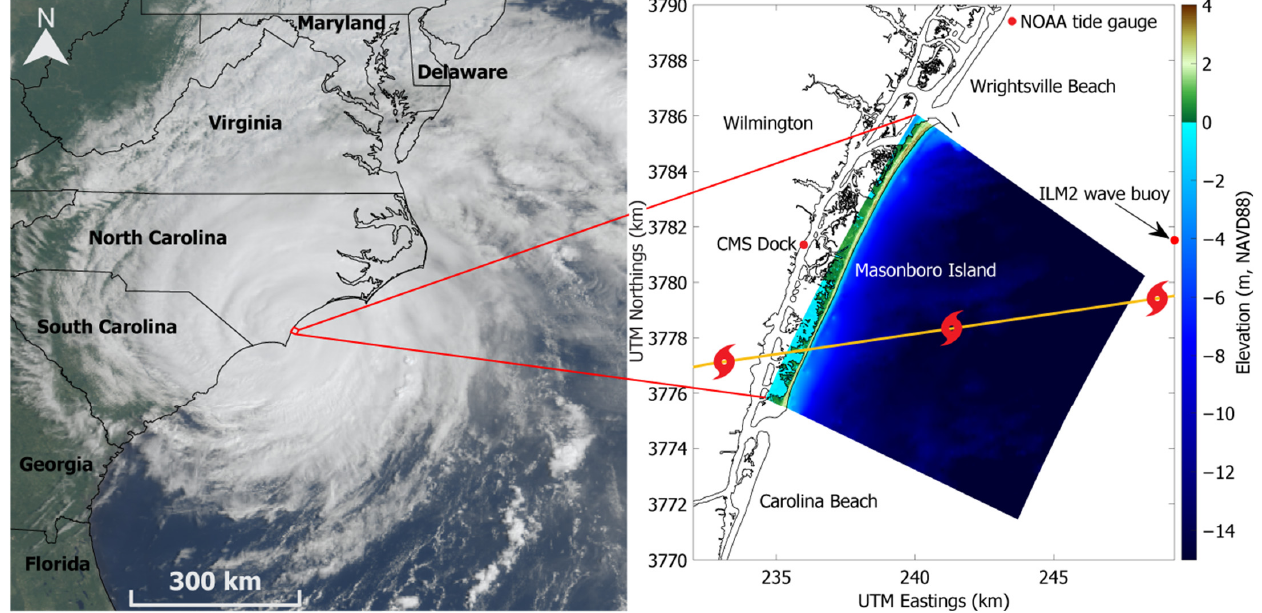
Figure 1. GOES-16 imagery of Hurricane Florence (14 September 2018) over Wilmington, North Carolina ( left ), and the XBeach model domain of Masonboro Island ( right ) with the best track of Hurricane Florence (orange line [31]).